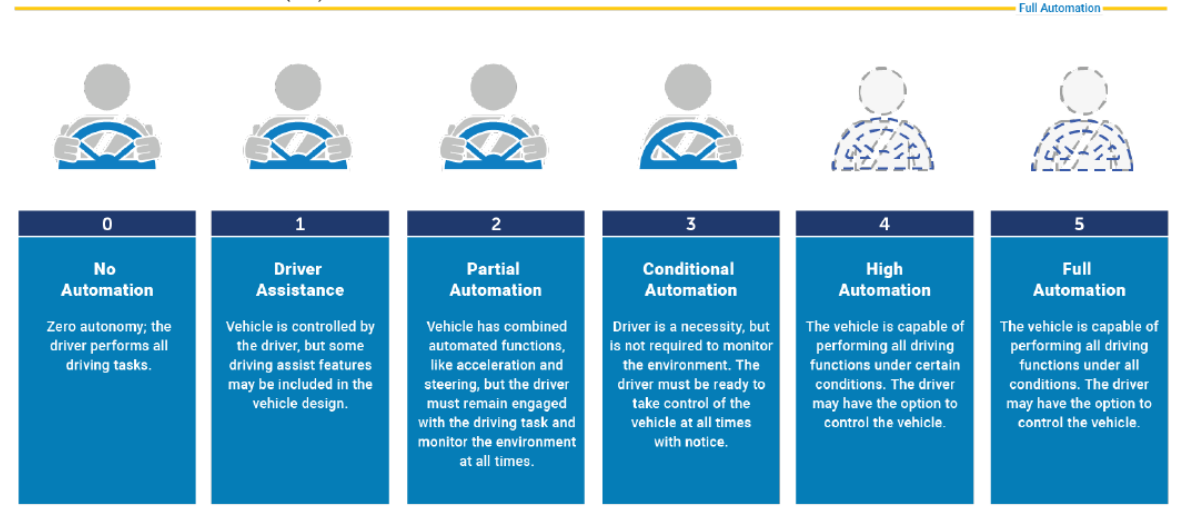
Figure 1. Society of automotive engineers automation